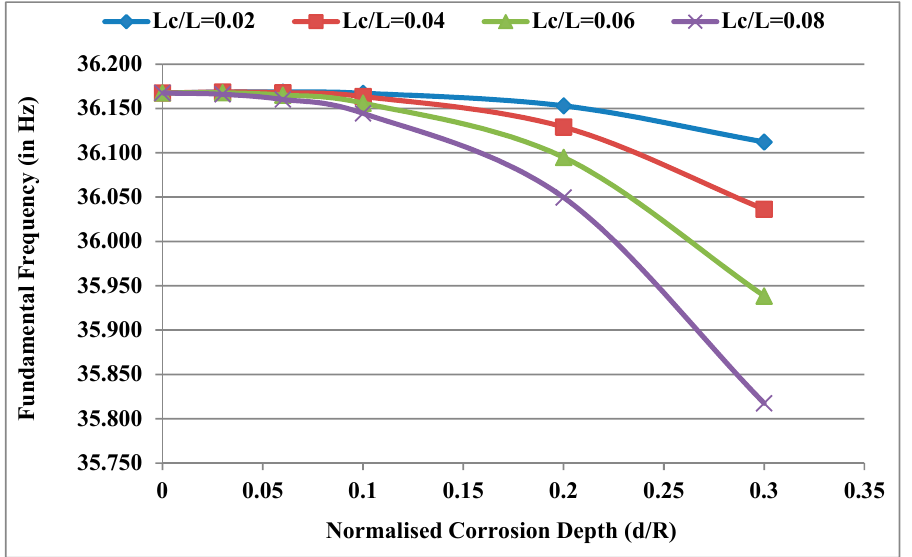
Figure 6. Effect of d/R for different lengths (L c /L) on the fundamental frequencies of the system. Figure 6. E ff ect of d / R for di ff erent lengths (L c / L) on the fundamental frequencies of the 5.3. Effect of X c /L for Different d/R Values on the Fundamental Natural Frequency of the System